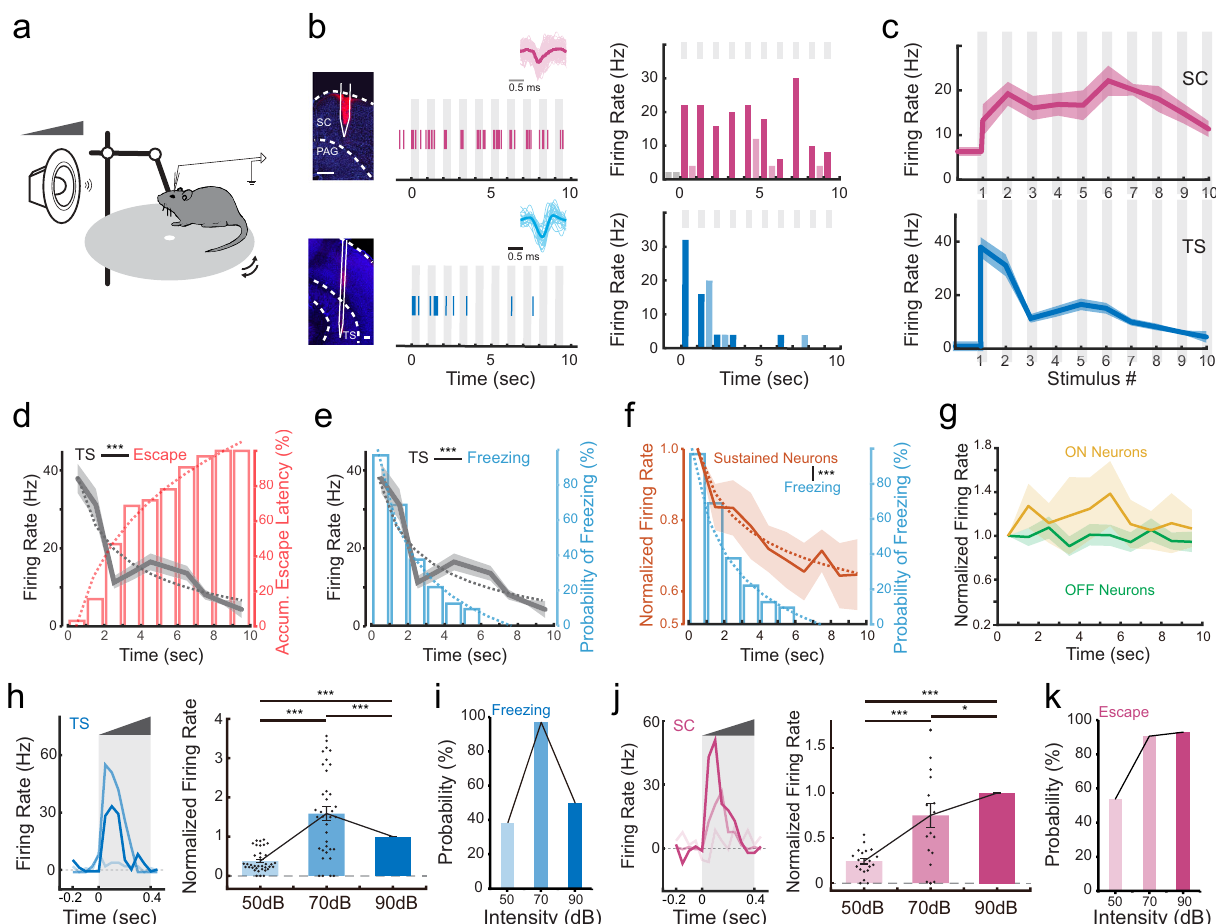
Fig. 5 Differential temporal dynamics of superior colliculus (SC) and the tail of the striatum (TS) neuron responses to crescendo stimuli. a Illustration of in vivo recording in the awake head- fi xed condition. b Left, example image showing track of the recording electrode in SC (top) or TS (bottom). Scale bars, 200 µ m. Middle, example single-unit response to a train of crescendo stimuli in SC (top) or TS (bottom). Each vertical line represents one spike. Grey column labels the duration of a sound stimulus. Superimposed individual spike waveforms and the average are shown in top insets (SC, n = 104 spikes; TS, n = 22 spikes). Right, corresponding PSTH. Dark and light-shaded colors represent spike rates during a sound stimulus (marked by grey column) and inter- stimulus intervals respectively. PAG periaqueductal gray. c Population average of evoked fi ring rate (analyzed for the duration of each individual stimulus) across10 crescendo stimuli ( n = 46 and 55 for SC and TS neurons respectively). Shade indicates s.e.m. d Comparison of the mean evoked fi ring rate of TS neurons across 10 stimuli and accumulative distribution of escape latencies. Dotted curve represents fi tting of the data. *** p < 0.001, r = − 0.92, Pearson ’ s correlation coef fi cient. e Comparison of the mean evoked fi ring rate of TS neurons across 10 stimuli and the probability of freezing over time. *** p < 0.001, r = 0.92, Pearson ’ s co r relation coef fi cient. f Comparison of the mean evoked fi ring of the sustained type of cortical L5 neurons and the probability of freezing over time. *** p < 0.001, r = 0.95, Pearson ’ s correlation coef fi cient. g Comparison of the mean evoked fi ring of the ON (yellow) and OFF (green) type of cortical neurons across 10 stimuli. ON neuron response vs. probability of freezing, p = 0.58, r = 0.20; OFF neuron res p onse vs. probability of freezing, p = 0.74, r = − 0.12, Pearson ’ s correlation coef fi cient. h , Evoked fi ring rate of an example TS neuron (left) and normalized responses of all the recorded TS neurons (right) to crescendo stimuli with different top intensities. Right, *** p < 0.001, one-way ANOVA with post hoc (Bonferroni) test, n = 36. i The probability of freezing to crescendo stimuli with different top intensities ( n = 13, 32 and 14 mice respectively). j Evoked fi ring rate of an example SC neuron (left) and normalized responses of all the recorded SC neurons (right) to crescendo stimuli with different top intensities. Right, *** p < 0.001, * p = 0.022, one-way ANOVA with post hoc (Bonferroni) test, n = 19. k The probability of escape to crescendo stimuli with different top intensities ( n = 13, 32 and 14 mice